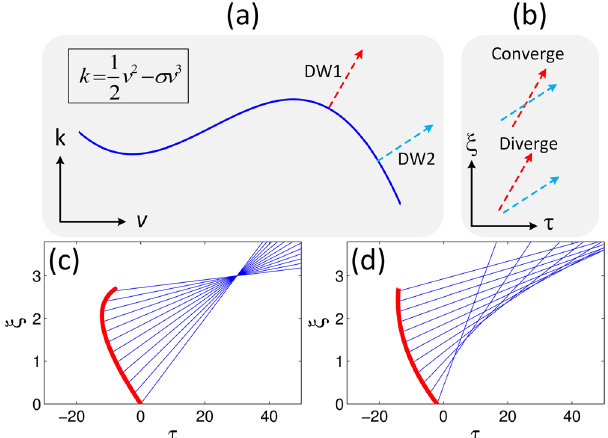
Figure 2. Description of the dynamical properties of dispersive waves (DWs) via ray tracing. ( a ) Sketch of a typical dispersion relationship defining the DW propagation direction. ( b ) Either divergence or convergence of the two dispersive waves shown in ( a ) can be achieved, depending on the point of origin of each individual DW. ( c ) and ( d ) show that the DWs (blue lines) can either focus to a point, or form a caustic, according to the trajectory followed by the pump pulses (red